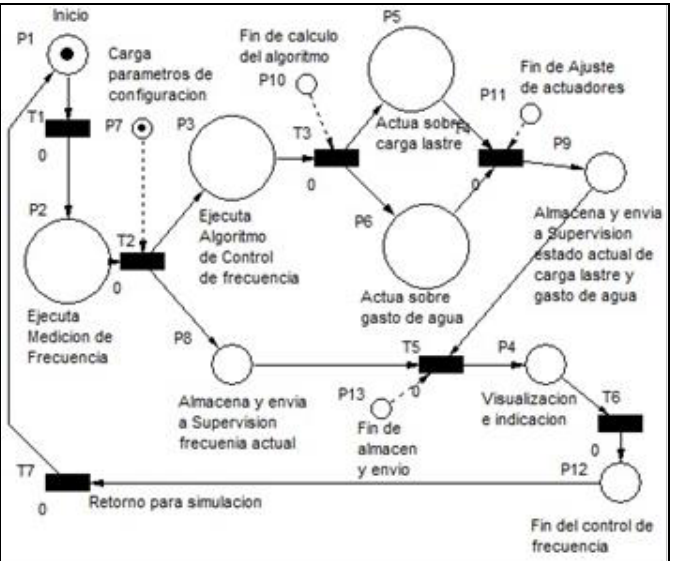
Figura 6: Diseño simplificado en GHENeSys del control de frecuencia dentro del Agente Minihidroelectrica. Fuente: Los autores, (2018).